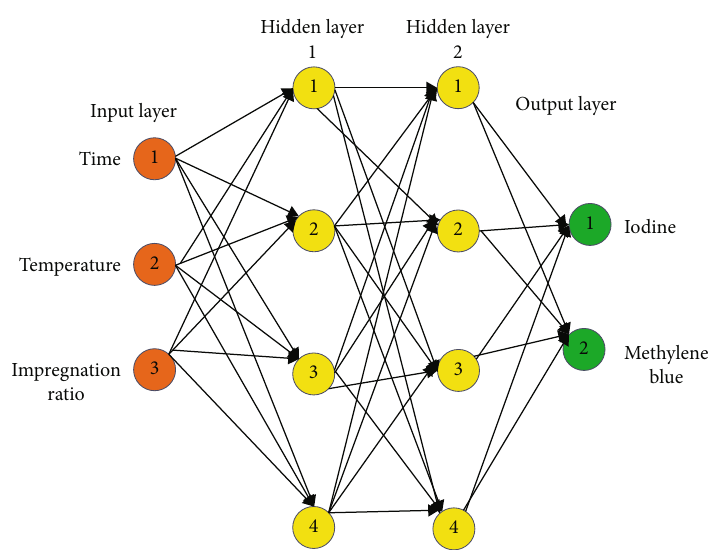
Figure 4: ANN structure of present research work.